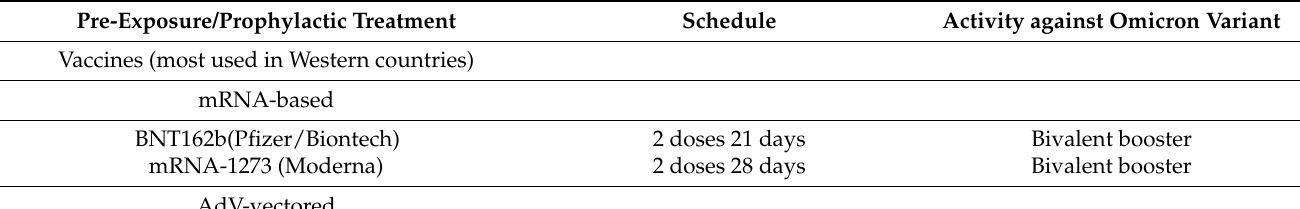
Table 3. Prophylactic and therapeutic options in patients with HM. Schedule of vaccines is reported based on the registration